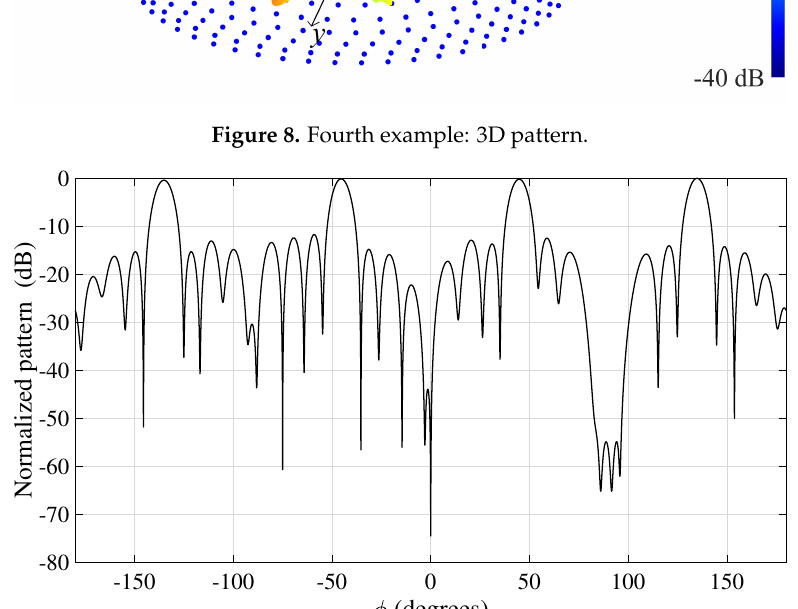
Figure 9. Fourth example: 2D pattern cut at θ = 30 ◦